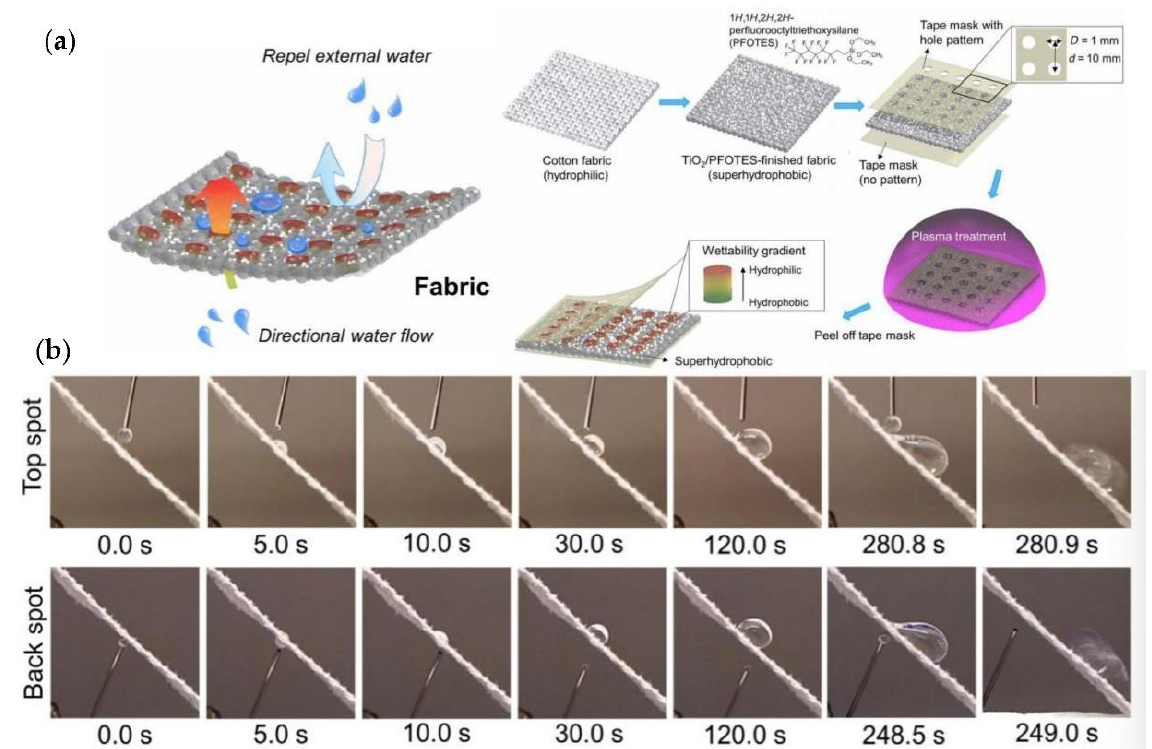
Figure 4. ( a ) Schematic illustration for the fabrication of a “skin-like” fabric with on-way water transfer and water repellency. ( b ) Water drops on the top side of the fabric (hydrophilic) and rolls off from the fabric without penetrating; water drops on the back spot (hydrophobic) and spontaneously are transported from the backside to the other side, and then roll off from the top surface [37] (Copyright 2020, Science Advance).